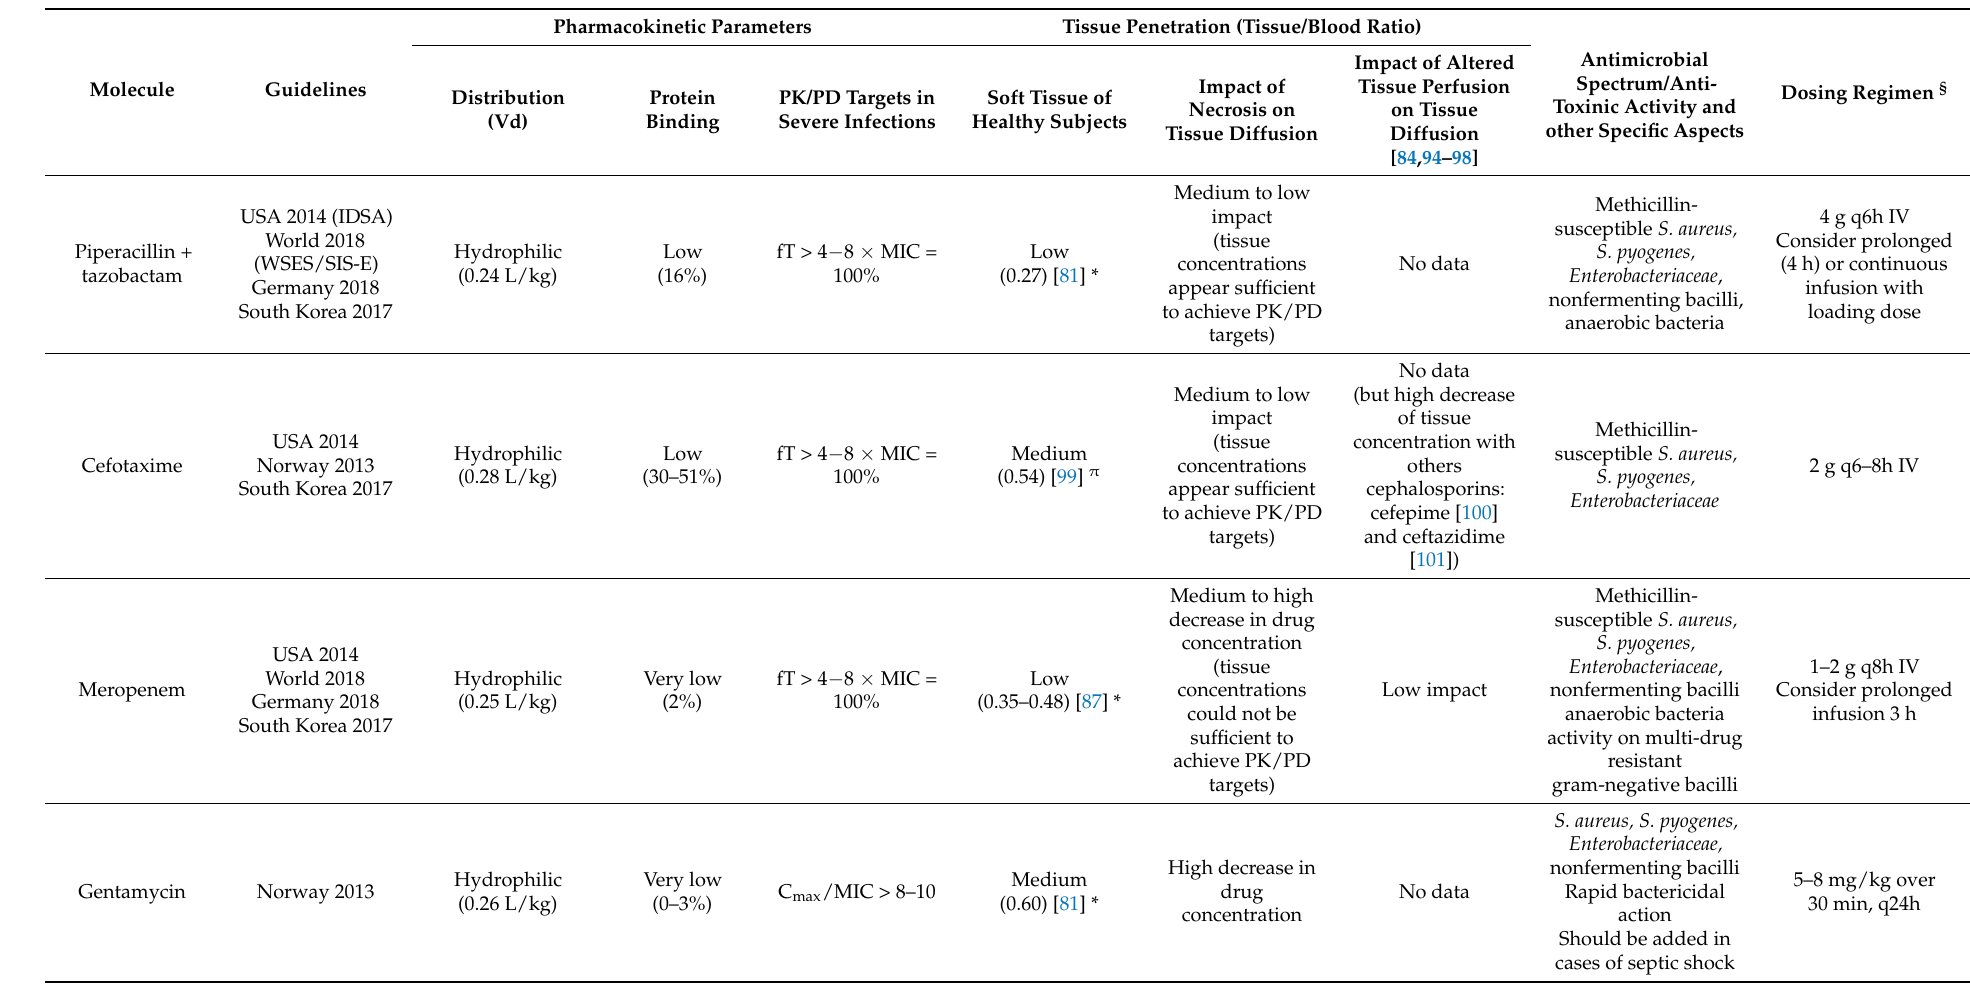
Table 2. Pharmacokinetics and pharmacodynamics characteristics of the main molecules recommended for the empiric treatment of NSTIs in the main international and national